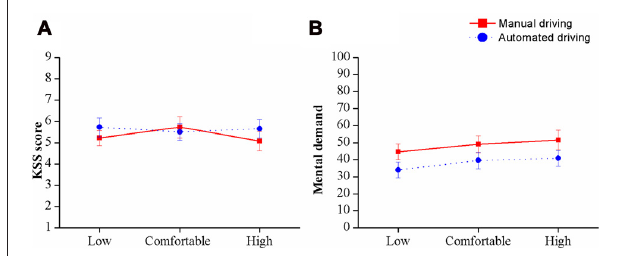
FIGURE 4 | Mean scores (and SE) on the Karolinska Sleepiness Scale (KSS) (A) and mental demand (B) in each